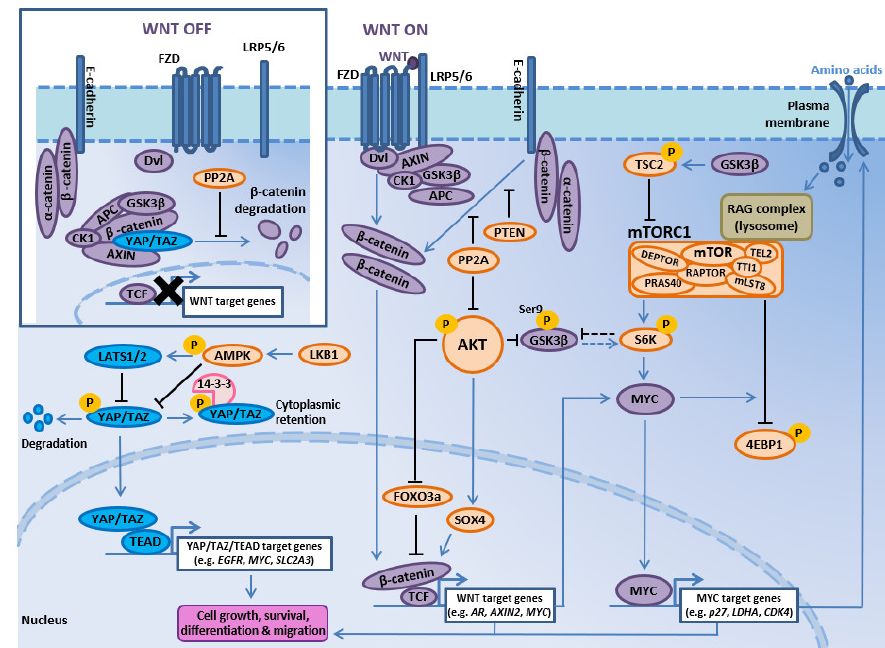
Figure 4. PI3K-AKT-mTOR and WNT signaling crosstalk. Upon ligand binding (WNT ON), the destruction complex is recruited to the plasma membrane leading to β-catenin accumulation in both the cytoplasm and nucleus, where it activates gene expression through TCF binding. Insert illustrates WNT signaling in the absence of WNT ligand (WNT OFF). The interplay between PI3K-AKT-mTOR and WNT may occur through shared pathway components (e.g., GSK3β, PTEN, PP2A) and/or the joint regulation of transcription factors such as MYC, FOXO3a, SOX4 or YAP/TAZ. CDK4, cyclin-dependent kinase 4; LATS1/2, L -type amino acid transporter 1/2; LDHA, L -lactate dehydrogenase A chain; SLC2A3, solute carrier family 2, facilitated glucose transporter member 3 (encoding GLUT3, glucose transporter 3); TAZ, transcriptional co-activator with PDZ-binding motif; TEAD, transcriptional enhanced associate domain transcription factor; YAP, Yes-associated protein.